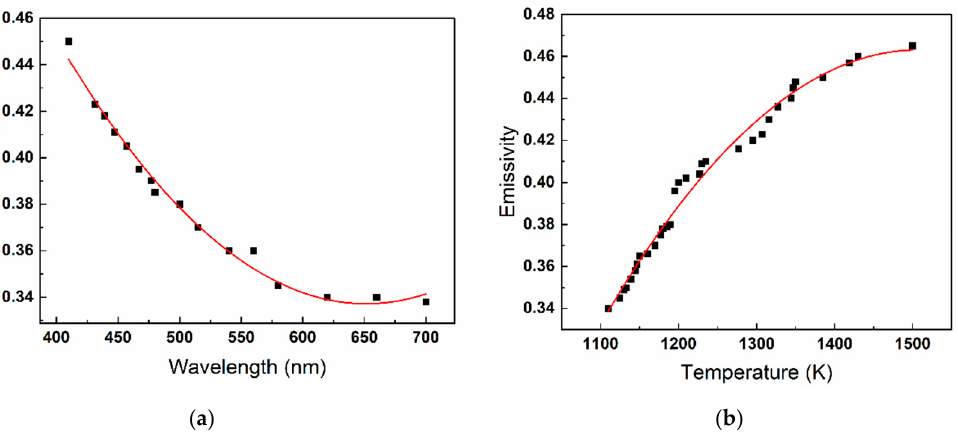
Figure 1. The relationship between wavelength and temperature with an emissivity of ordinary car- bon steel in different conditions (online version in color.): ( a ) wavelength in 1147 K; ( b ) temperature in 665 nm.